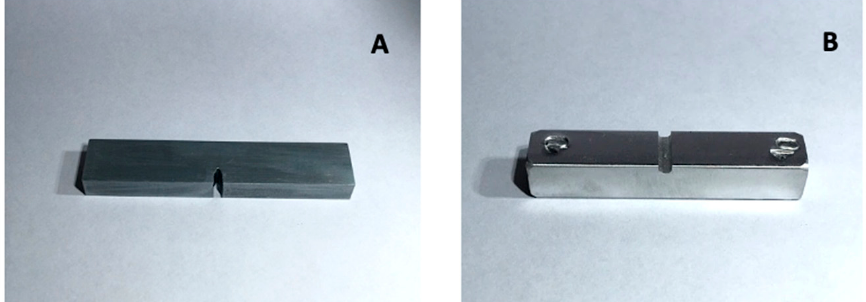
Figure 3. Aluminum alloy specimens: ( A )—specimen for the tensile strength measurements, and ( B )—specimen for the impact strength measurements. In case of all grades of aluminum alloys and for both types of measurements, each measurement was repeated 15 times. The mean square error to calculate the measurement errors was used. The research scheme is shown in Figure 4.